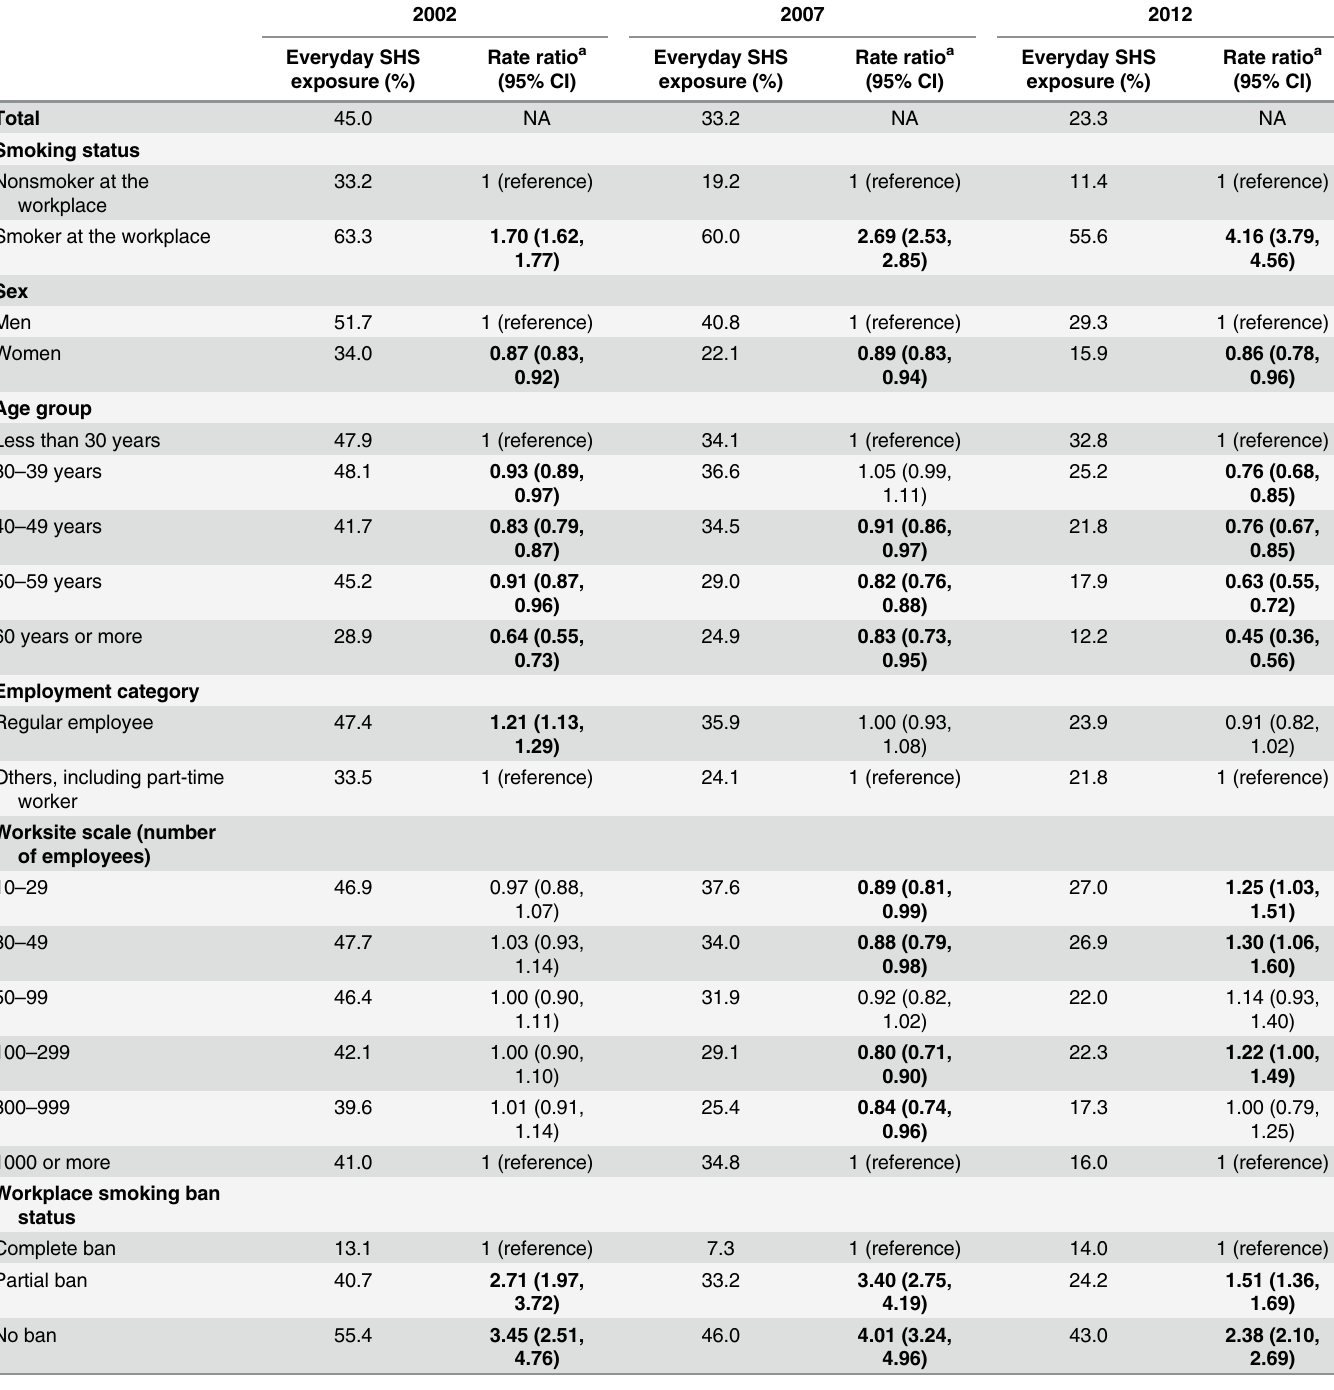
Table 4. Trends in prevalence and rate ratio for everyday workplace SHS exposure from other people among employees according to characteris- tics (weighted